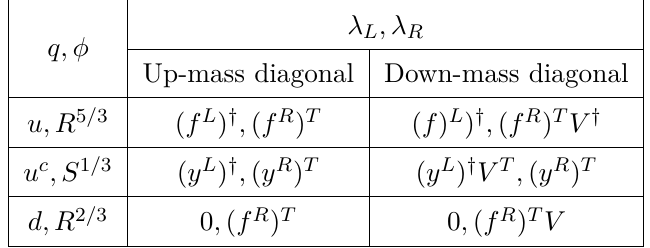
Table 1 . Mapping of Yukawa couplings of eq. (2.5) into λ L,R . Note that, in this table, u c is defined as charge conjugate of up-type quarks, namely u c = C ¯ u T